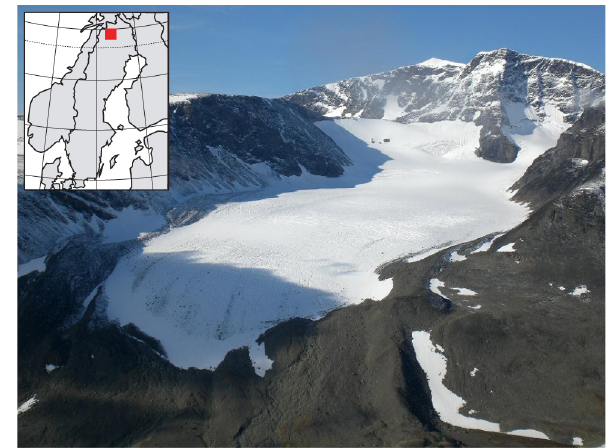
Fig. 1. Storglaci¨aren in northern Sweden with Kebnekaise Moun- tain in the background. View to the west. Photo taken by T. Koblet in September